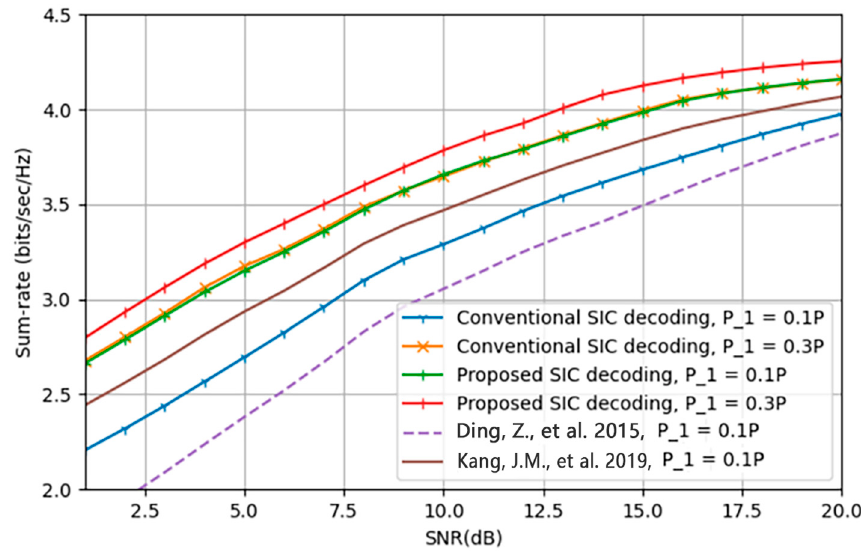
Figure 7. Sum rate versus SNR for the conventional and proposed SIC schemes with varying power allocations